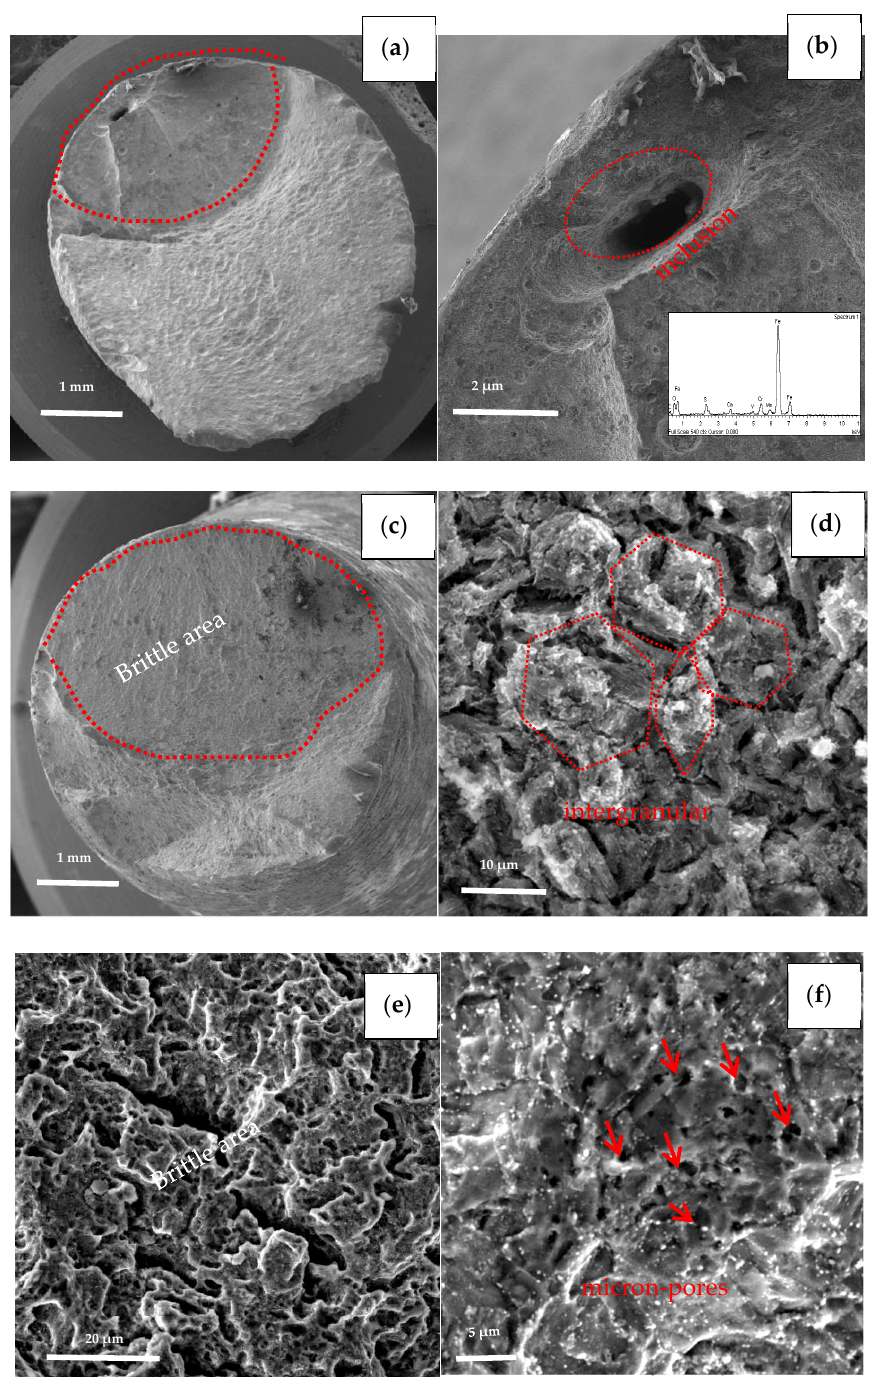
Figure 9. Fracture surfaces morphologies of the earliest broken specimen ( a , b ) and the last broken specimen ( c – f ).